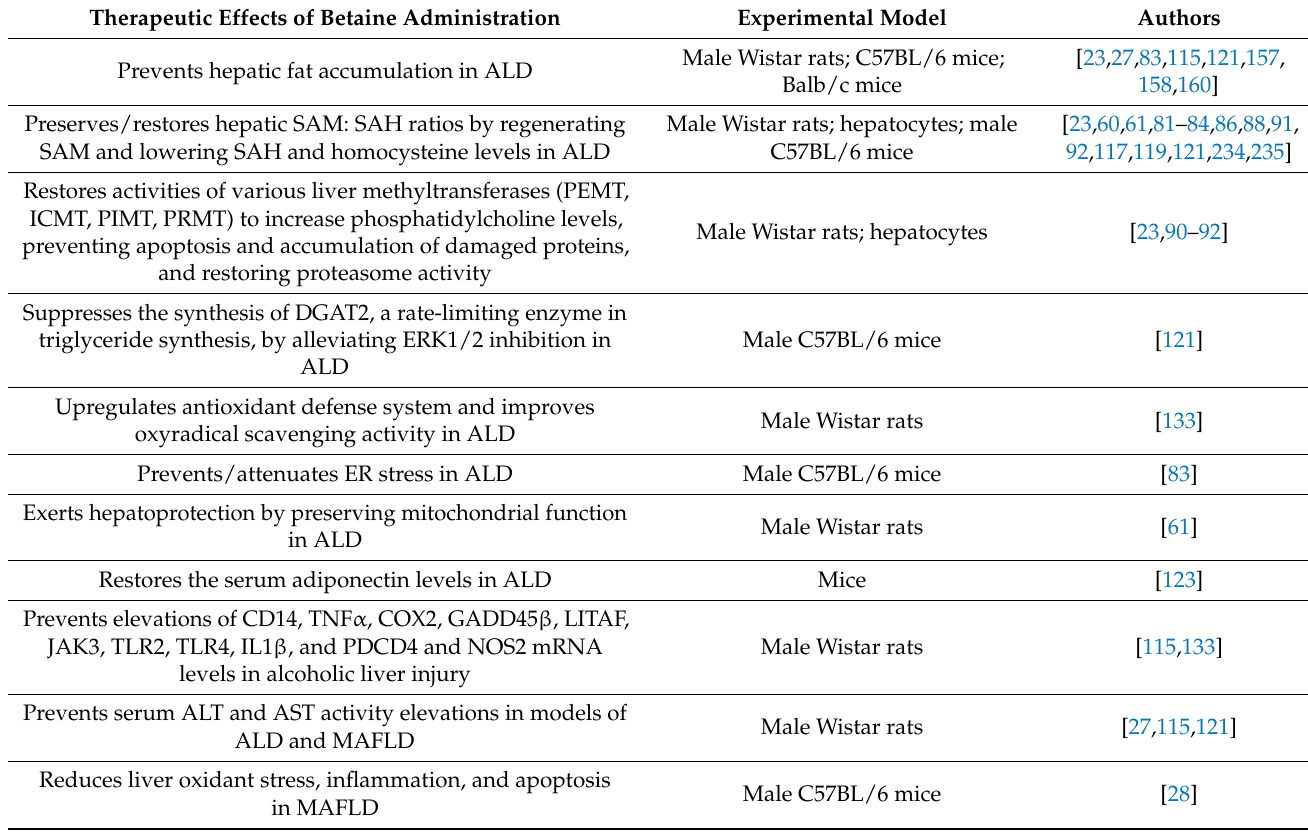
Table 1. Protective effects of betaine in experimental animal models, cell culture systems, and clinical studies. Therapeutic Effects of Betaine Administration Experimental